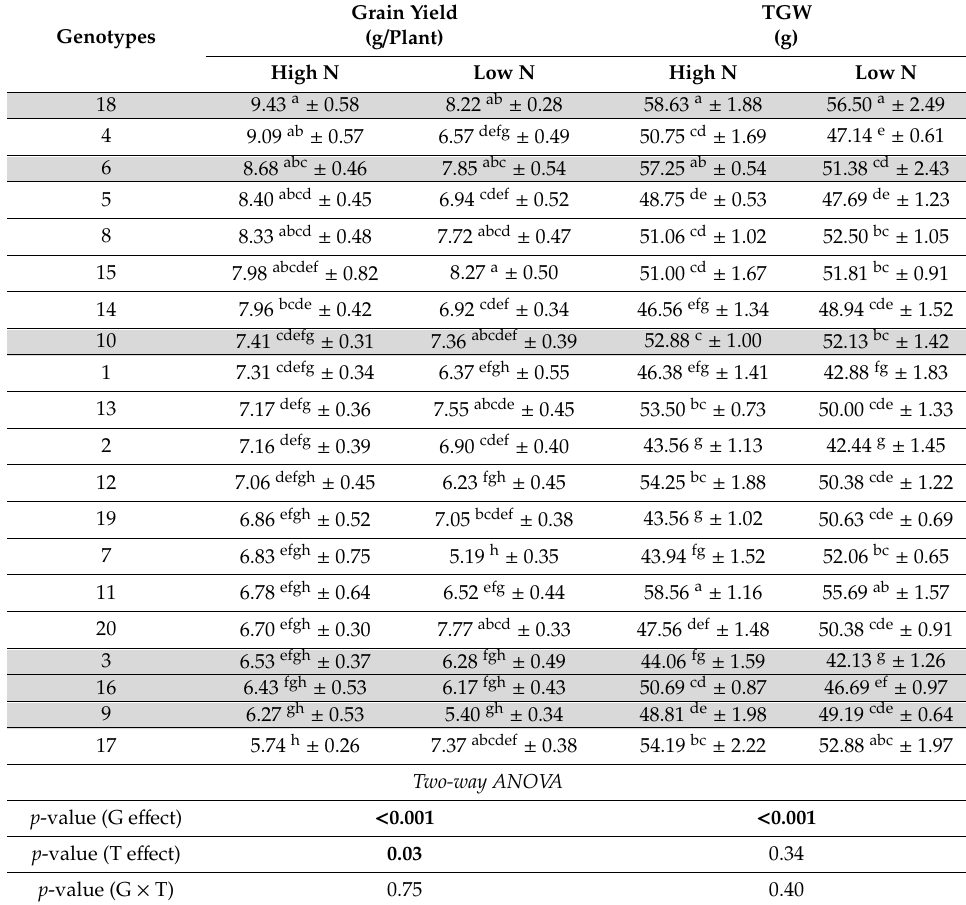
Grey shading indicates the genotypes that were selected for grain quality analyses. Within each treatment, letters indicate significance di ff erences between genotype. At p < 0.5. Values in bold indicate significance ( p < 0.05). G: Genotype, T: